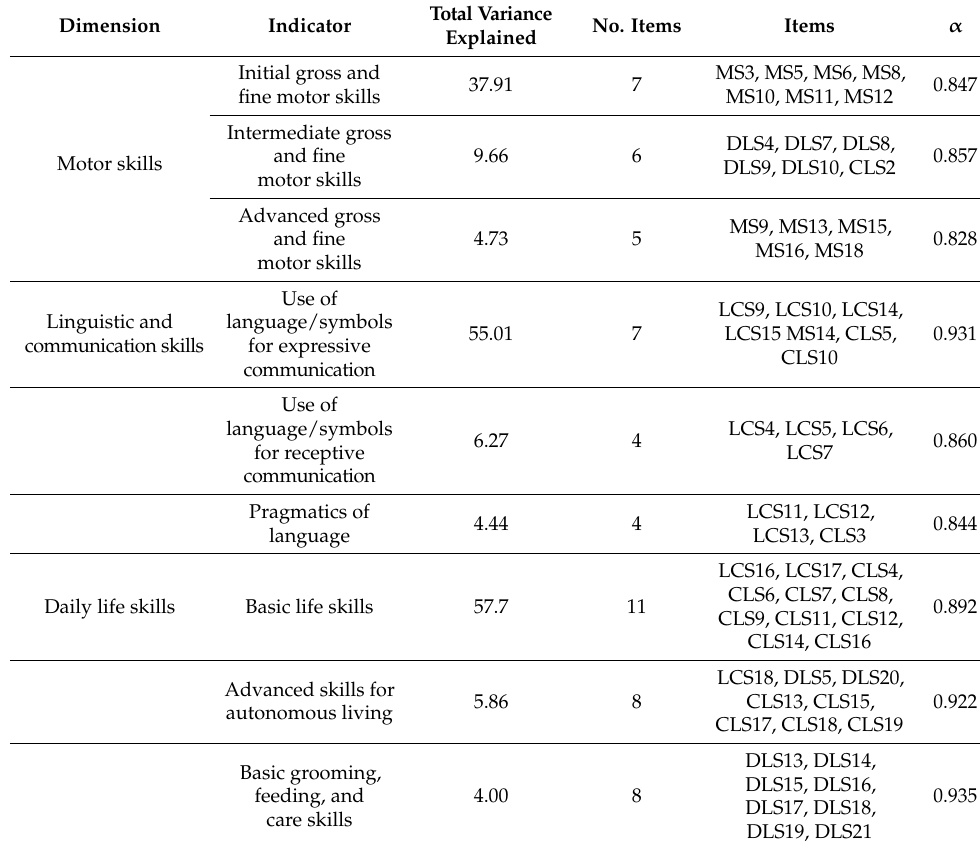
Table 4. Final exploration of the sub-dimensions of the questionnaire: items and reliability by subscale. Total Variance No. Items Items Dimension Indicator Explained